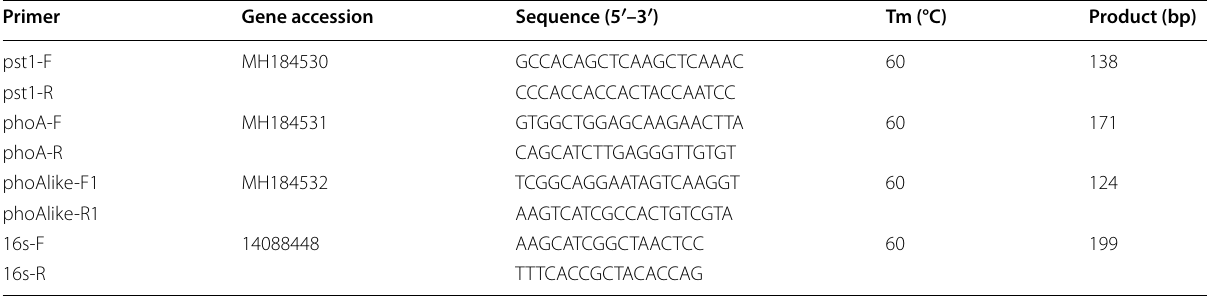
Table 2 Primers used to quantify the transcriptional activity of alkaline phosphatase and phosphate transporter genes in Anabaena sp. FACHB